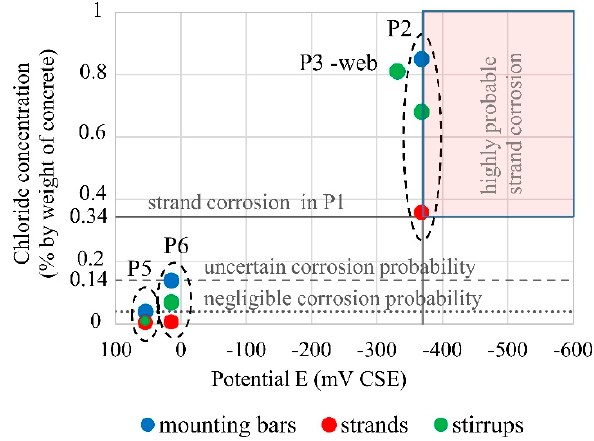
Figure 18. HCP and chloride concentrations for sampling locations in Girder 2. The chloride concentration at the level of the corroding strand in location P1 (in Girder 11) is included for comparison.